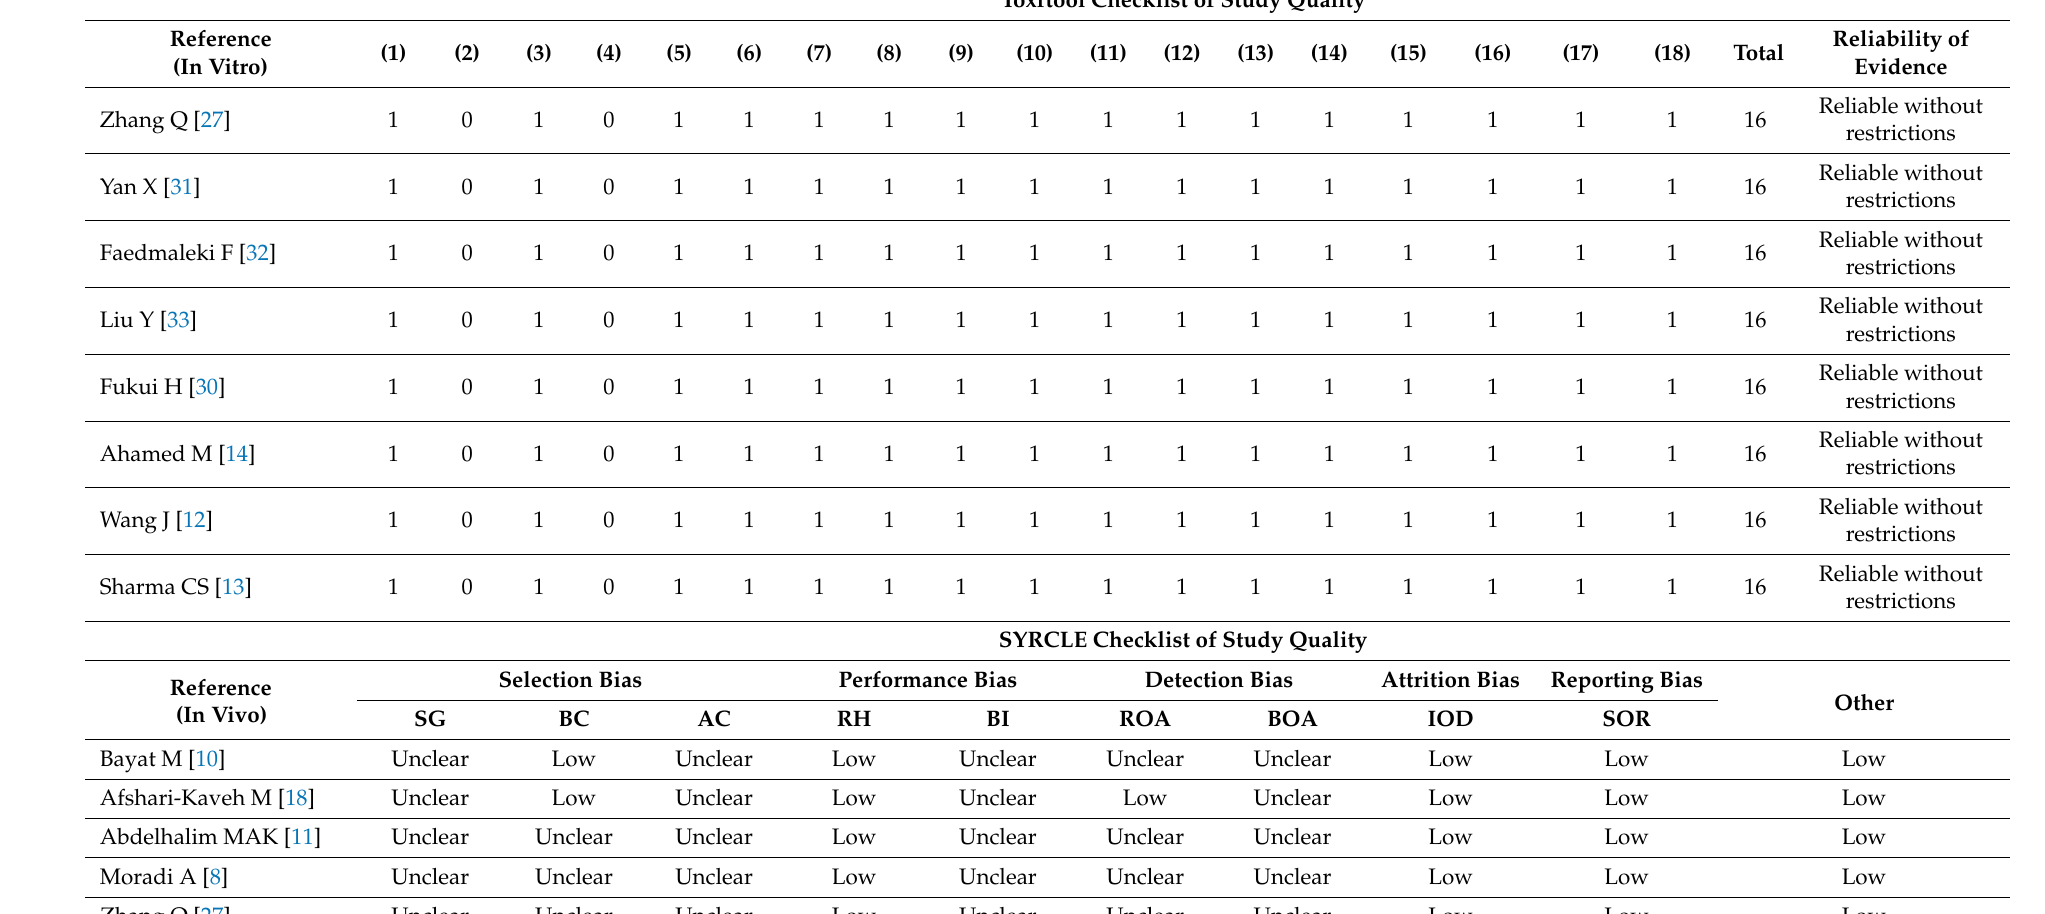
Table 2. Quality